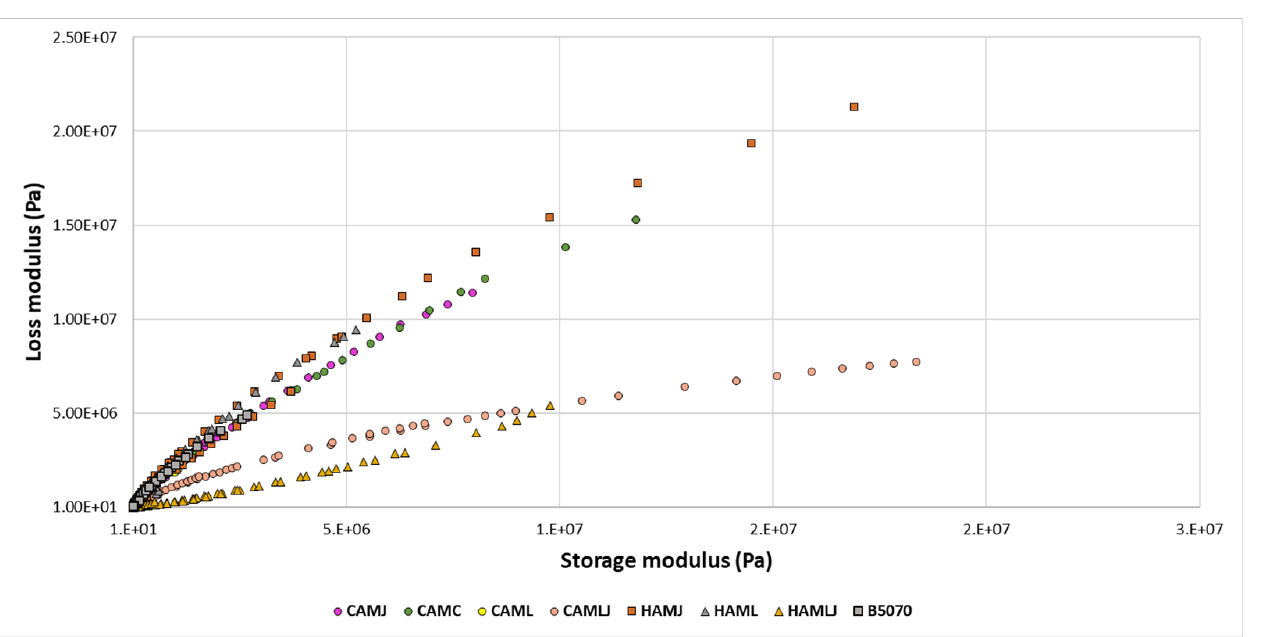
Figure 12. Cole-Cole diagram comparing all asphalt mastics.